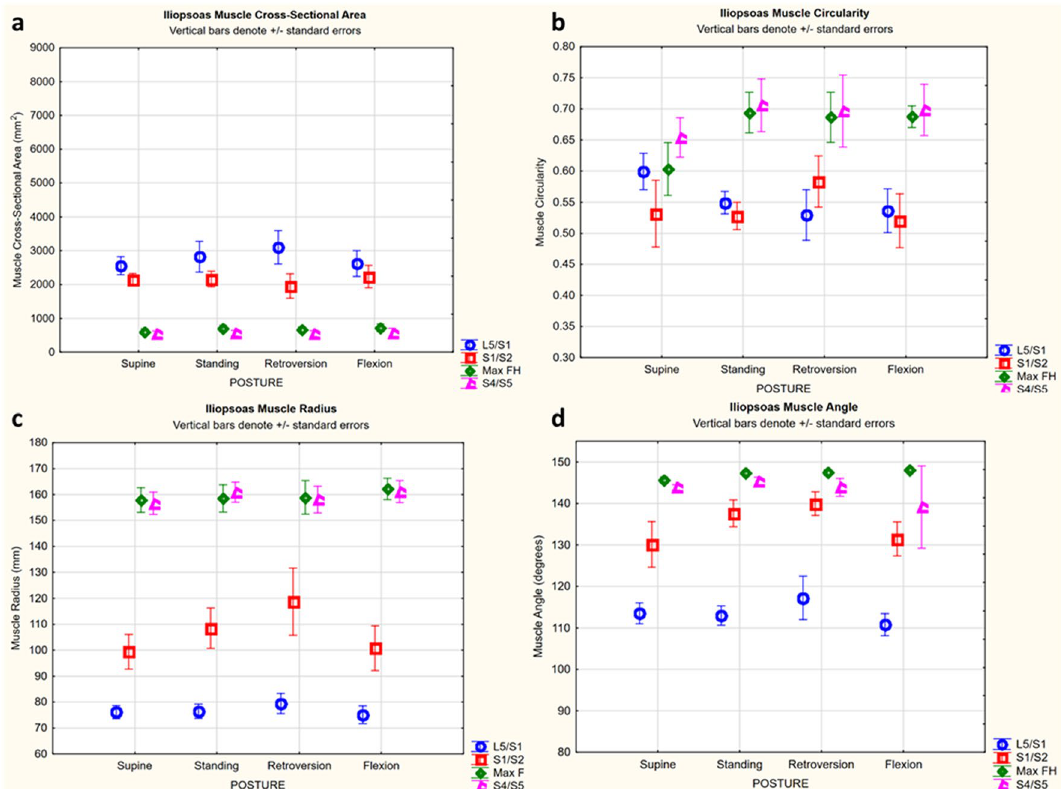
Figure 4. Mean (± SEM) iliopsoas muscle parameter for each posture shown by level. ( a ) CSA: there was a significant effect of level (Newman–Keuls significant: between all levels). At L5/S1 there was also an interaction with posture (Newman–Keuls significant: supine to retroversion, 17% increase; flexion to retroversion, 15% increase). ( b ) Circularity: there was a significant effect and interaction of posture and level (Newman–Keuls significant: L5/S1 supine to flexion, 12% decrease; L5/S1 supine to retroversion, 13% decrease; max FH supine to standing, 13% increase; supine to flexion, 12% increase; supine to retroversion 12% increase). ( c ) Radius: there was a significant effect and interaction of posture and level (Newman–Keuls significant at S1/S2: supine to standing, 8% increase; supine to retroversion, 16% increase; standing to retroversion, 8% increase; flexion to retroversion, 15% increase). ( d ) Angle: there were significant effects of both posture and level (Newman–Keuls significant: between all levels, 5–22% increase; supine to retroversion, 3% increase; standing to flexion, 3% decrease; retroversion to flexion, 4% decrease).